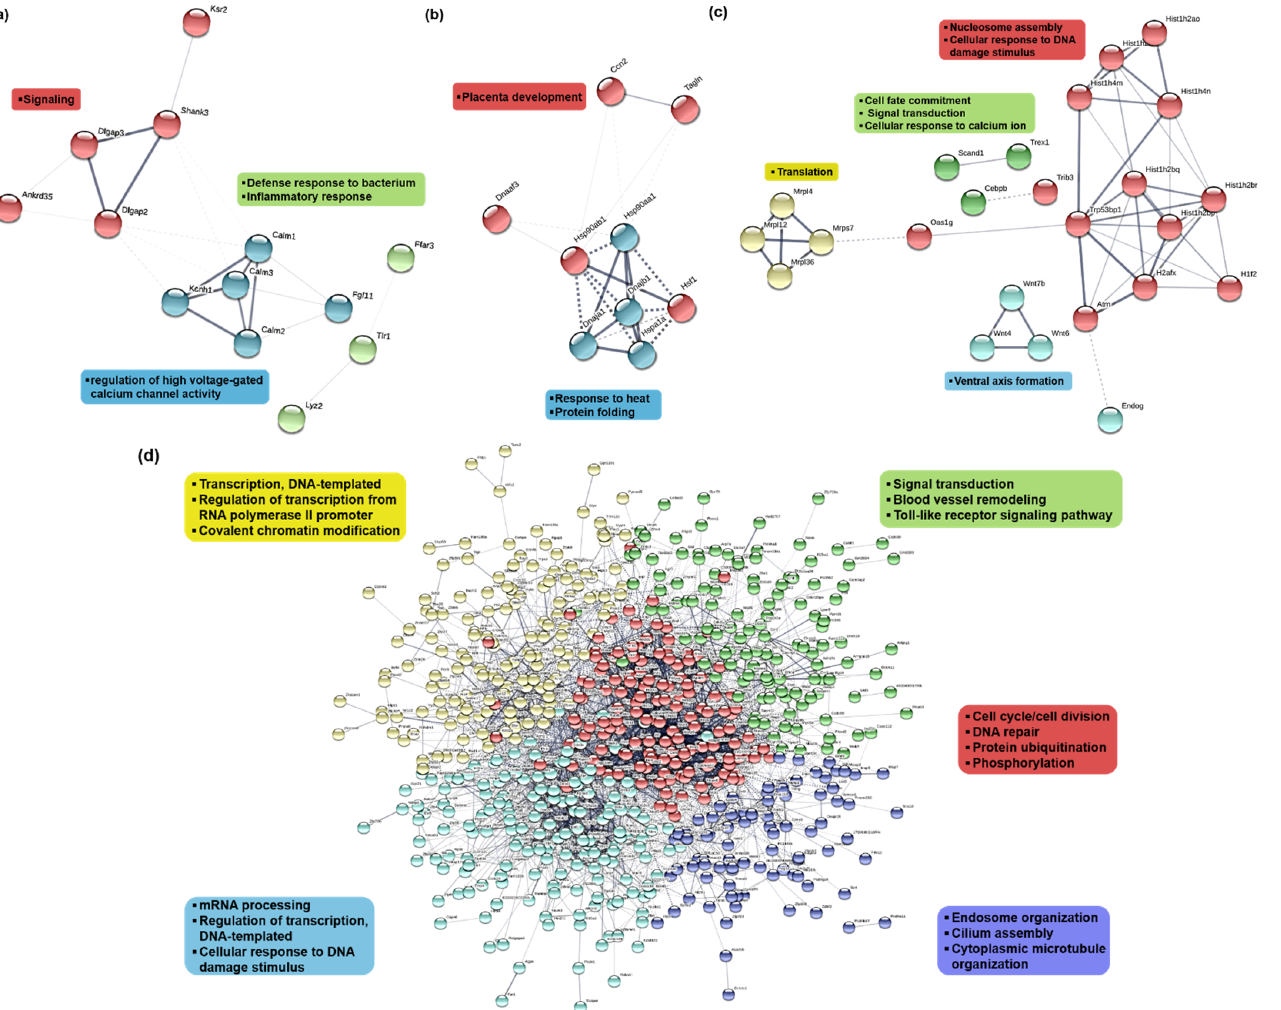
Figure 3. Protein interaction network of DEGs in Neuro2a cells in response to ethanol. Protein interaction networks of DEGs were mapped using the STRING database. ( a , b ) Protein interaction network of genes upregulated and downregulated, respectively, in E24h compared to the control. ( c , d ) Protein interaction network of genes upregulated and downregulated, respectively, in E72h compared to the control. Each protein (node) is connected by a line, the thickness of which depicts confidence in the association (line thickness indicates the strength of the data support).